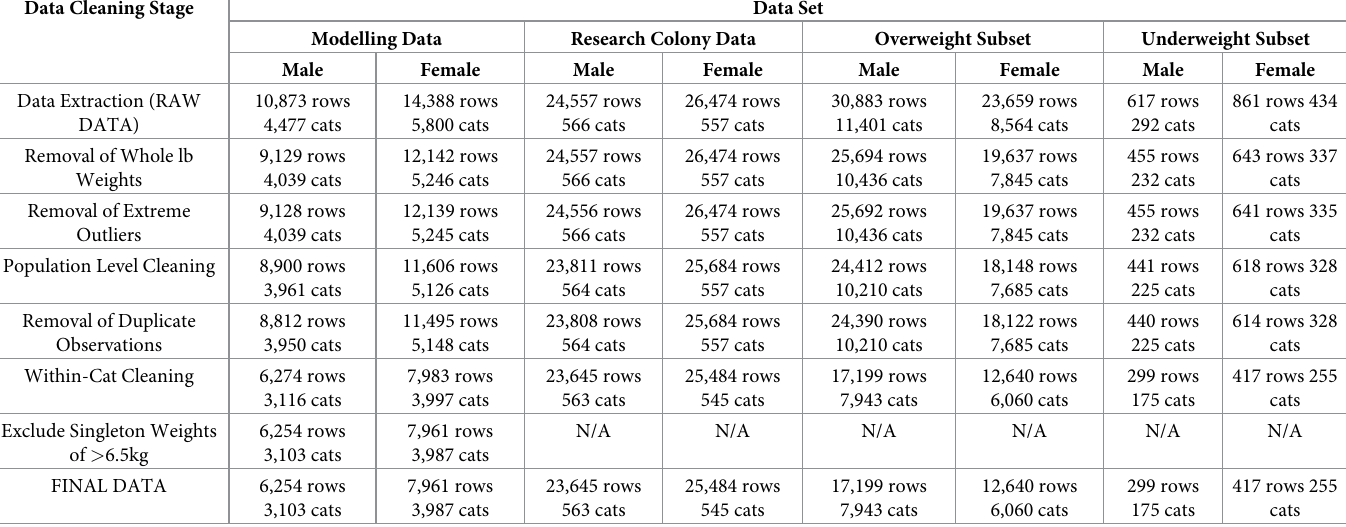
Table 1. Details of data sets at each stage of data